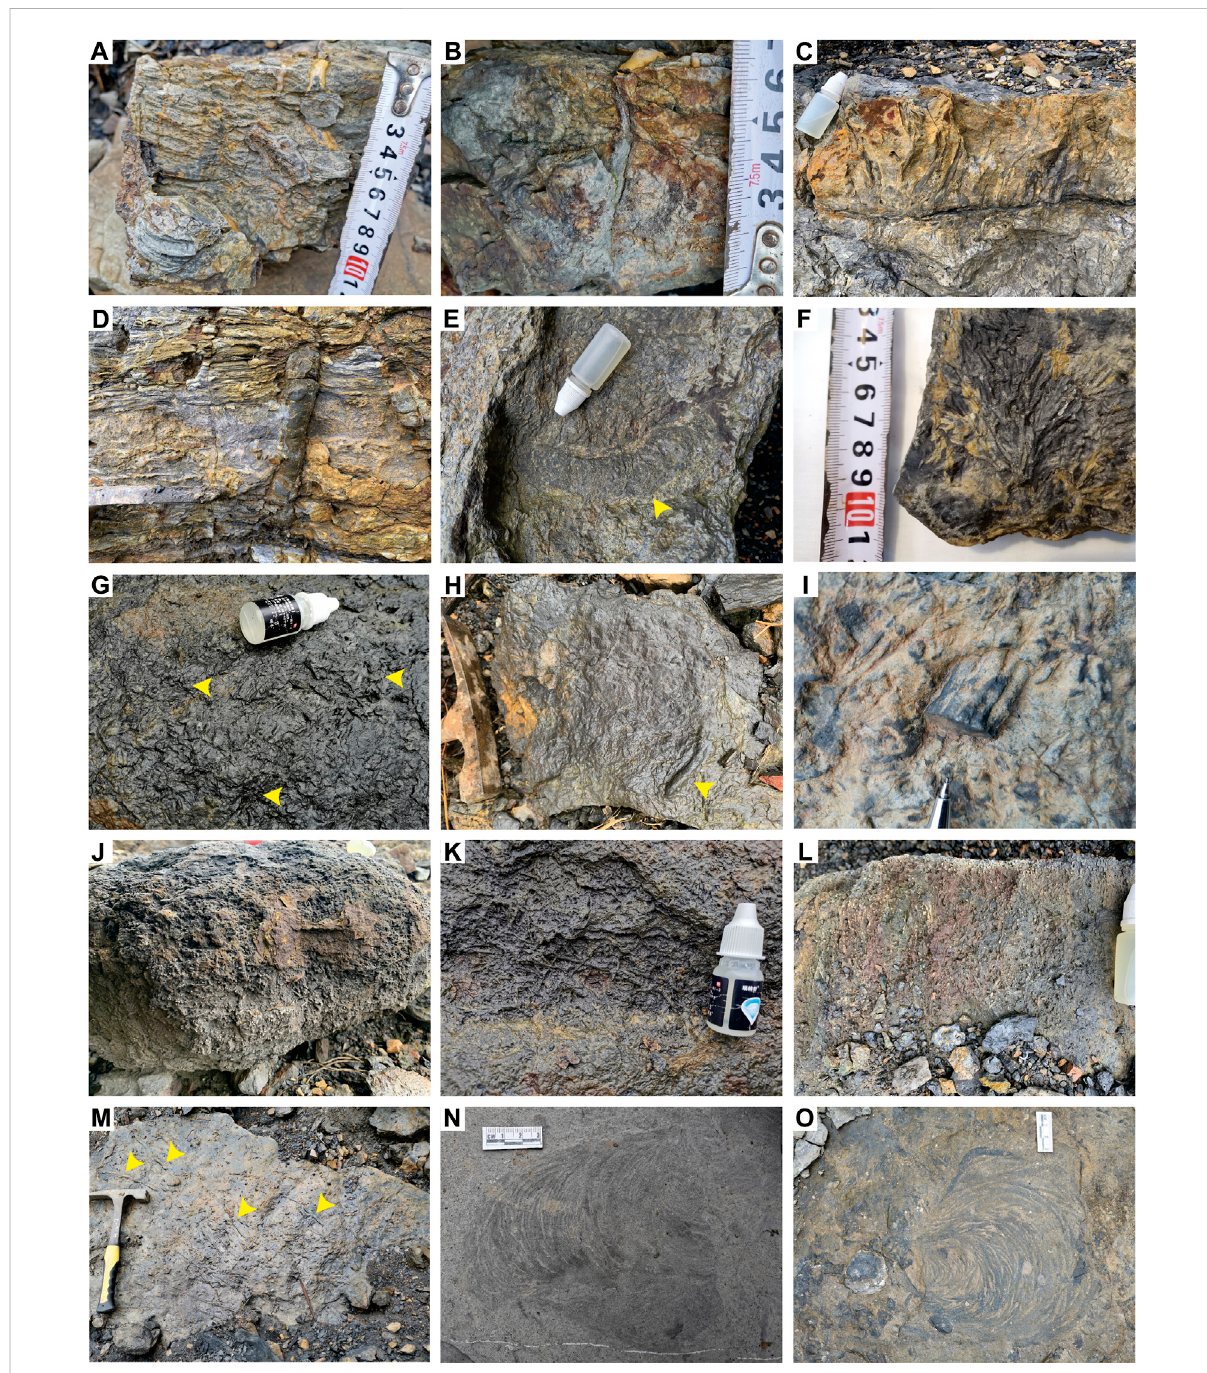
FIGURE 8 Trace fossils in the Jiusi Formation. (A – C) Cross-section view of the Skolithos linearis in lithofacies Sb (bioturbated sandstones). (A,B) Section LDZ; (C) sectionDHZ;cross-sectionview (D) andbedding-planeview (E) ofthe Ophiomorpha isp.InlithofaciesSb,sectionLDZ. (F,G) Bedding-plane view of the Chondrites fi lifalx in lithofacies Hb (F) and lithofacies Mb (G) , section LDZ (H,I) bedding-plane view, and (H) cross-section view of the Palaeophycus sp. In lithofacies Sb, section LDZ. (J – L) The bioturbated siltstone and trace fossils were dominated by Chondrites sp. (J) Cross- section view (K) and bedding-plane view (L) of (J) . (M) Planolites sp. In lithofacies Sb, section LDZ. (N,O) Bedding-plant view of Zoophycos cf. shandongensis (N) and Zoophycos sp. (O) section